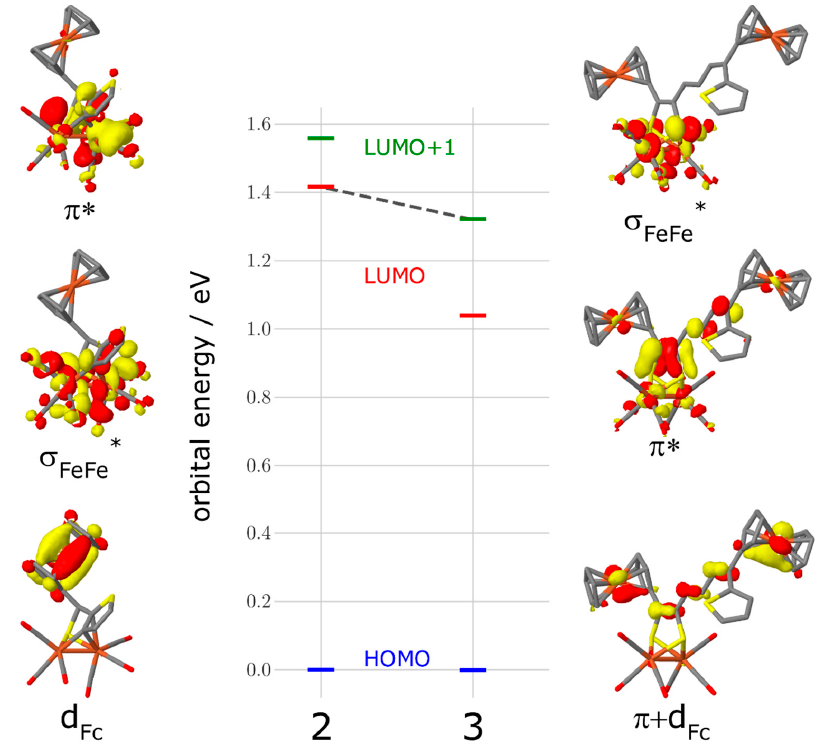
Figure 5. Orbital energy and orbital pictures of the HOMO, LUMO, and LUMO+1 for complex 2 (left) and complex 3 (right). The grey dashed line between complex 2 -LUMO and complex 3 -LUMO+1 highlights the change in the orbital order for the relevant σ * character orbital at the active [Fe–Fe] center.